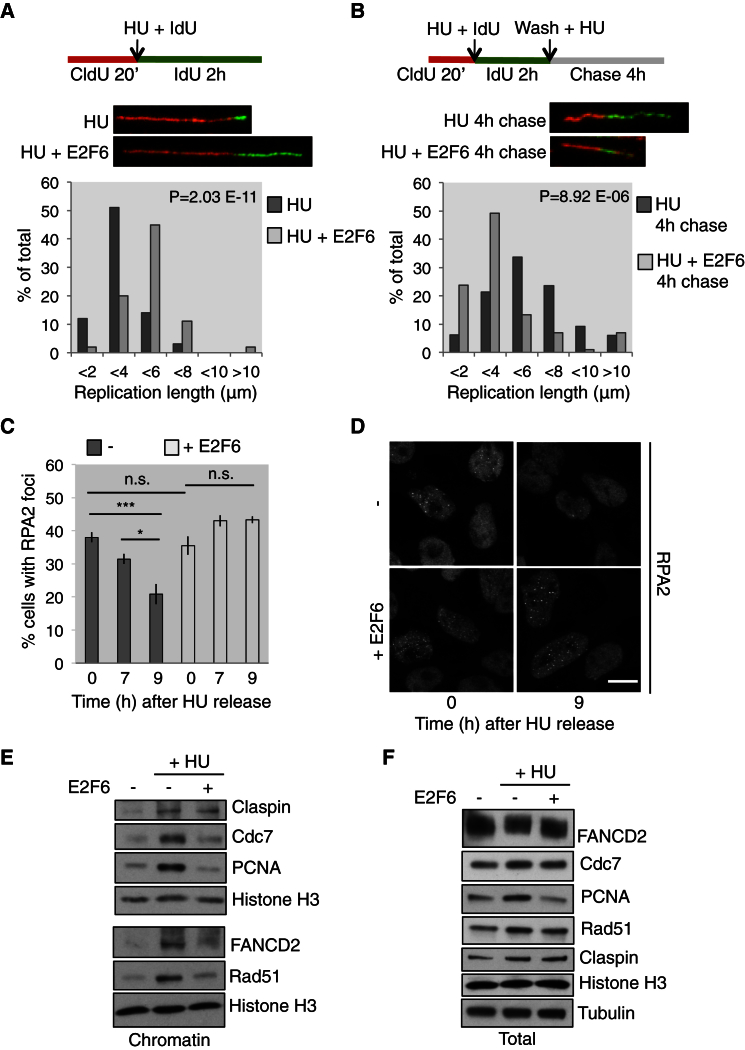
Sustained E2F Transcription Is Necessary for Checkpoint Functions(A) DNA fiber analysis schematic and representative images of individual fibers, HEK293 T-Rex E2F6 cells. Bar graphs of green track length, 2 hr HU −/+ E2F6 (Doxy 2 μg/ml). p, significantly longer tracks with E2F6; Student’s t test.(B) Schematic and representative images, HEK293 T-Rex E2F6 cells. Bar graphs of green track length, 4 hr chase in HU −/+ E2F6 (Doxy 2 μg/ml). p, significantly shorter tracks with E2F6; Student’s t test.(C) Bar graph of % cells with RPA2 foci at times shown after release from 16 hr HU −/+ E2F6 (Doxy 2 μg/ml). n = 3; >130 for each; error bars = SEM. ∗∗∗p < 0.001; ∗p < 0.05 with ANOVA and Tukey’s.(D) Representative images for (C). The scale bar represents 10 μm and is the same for all.(E) Western blot of chromatin preparation, RPE1 TetON E2F6 cells, 7 hr, treatments shown. E2F6, Doxy 2 μg/ml.(F) Western blot of WCE, RPE1 TetON E2F6 cells, 7 hr, treatments shown. E2F6, Doxy 2 μg/ml.See also Figure S3 and Movies S1 and S2.